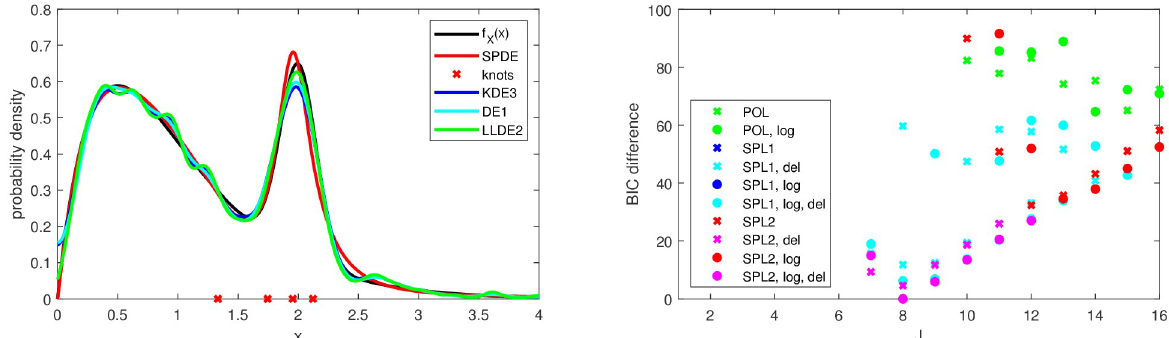
Fig 4. Test case 15: Example of density estimates from selected methods (left) and corresponding model selection for the SPDE (right). Only the best spline model after each knot deletion step is indicated to increase the readability of the plot. The SPDE is the model SPL2 with 4 knots after knot deletion augmented with a logarithmic boundary term. The sample size is N = 2000.